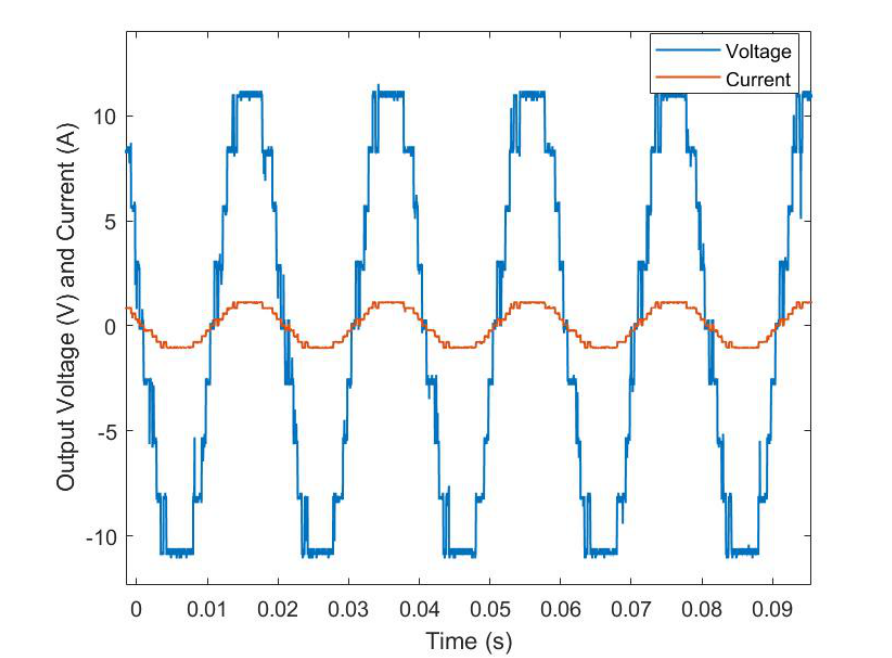
Figure 9. Fourcell battery block output voltage and current when connected to a resistive